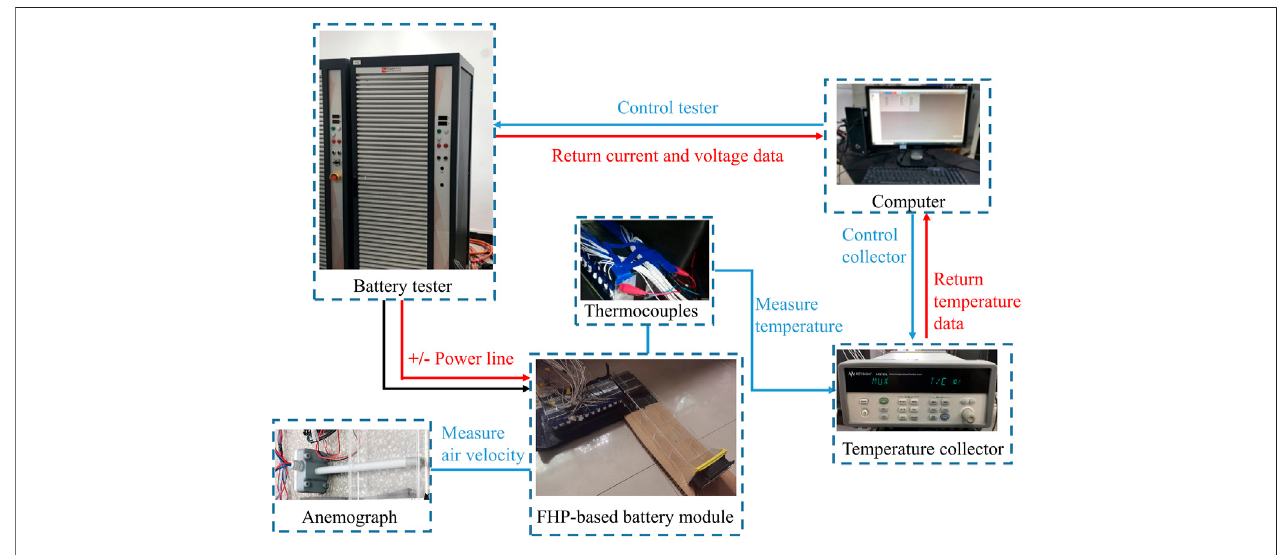
FIGURE 4 | Schematic representation of the experimental system devices.